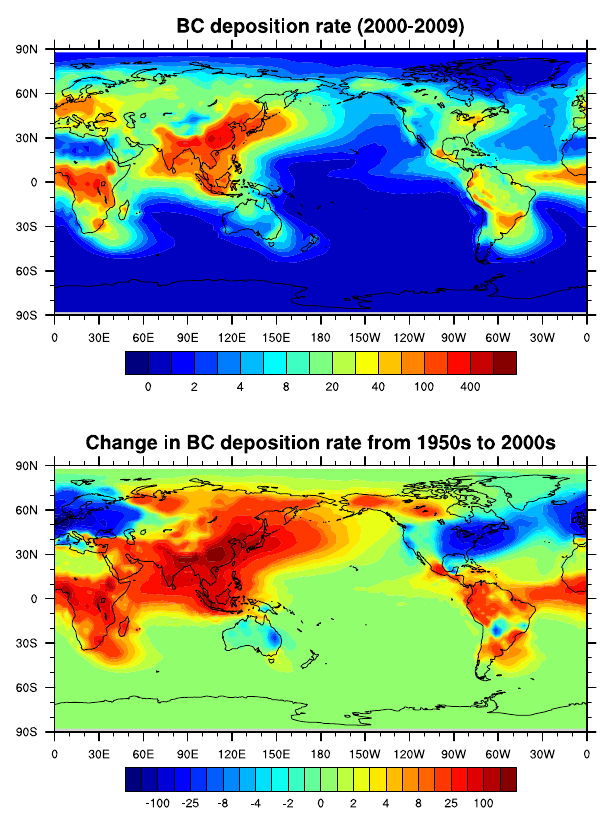
Figure 4. Annual mean BC deposition flux (mgm − 2 yr − 1 ) during 2000–2009 (top) and annual mean BC deposition flux change from the 1950s to 2000s